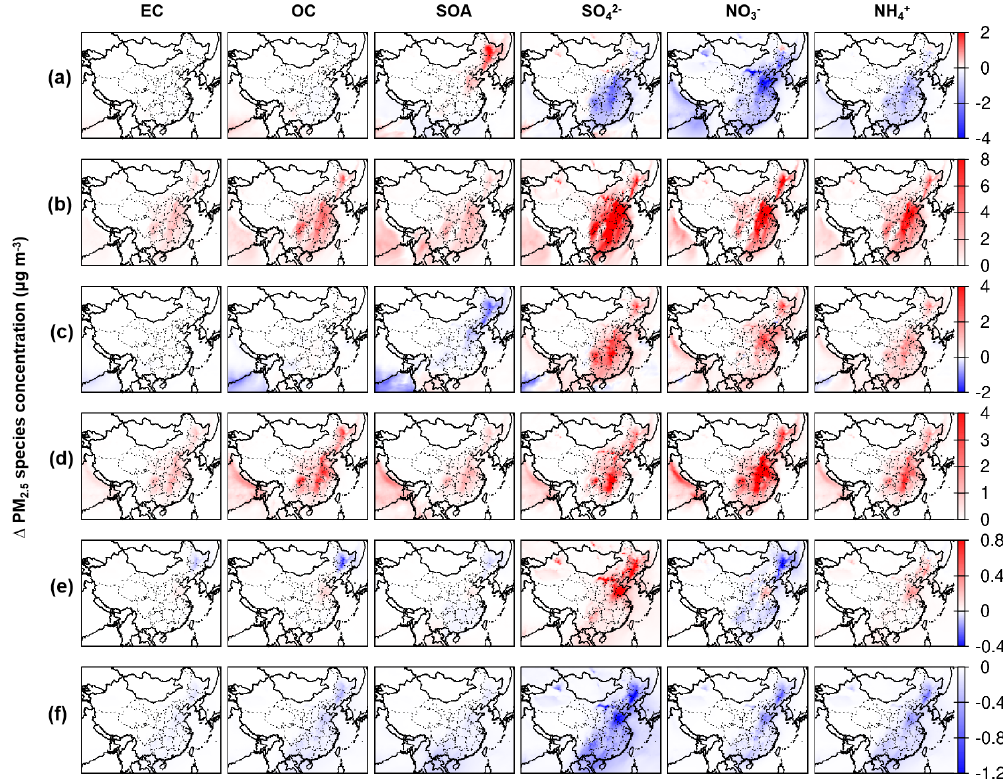
Figure 5. Changes in monthly average PM 2 . 5 component concentration (µgm − 3 ) in January due to (a) T + 1 . 0K, (b) WS − 10%, (c) AH + 10%, (d) PBLH − 20%, (e) CLW + 10%, and (f) PCP +